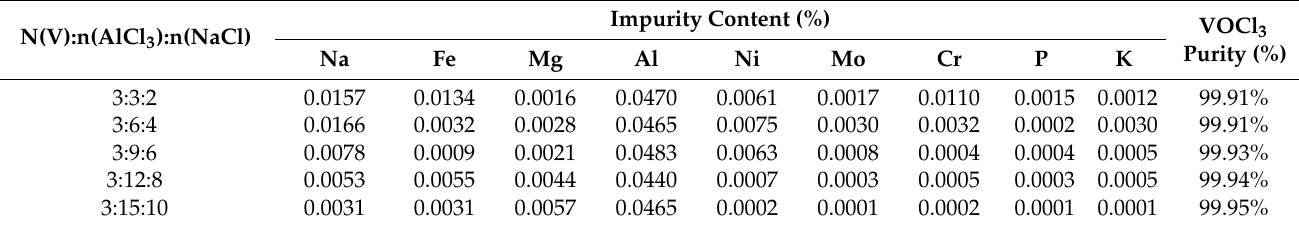
Figure 9. E ff ects of AlCl 3 and NaCl dosage on the vanadium extraction rate. Figure 9. Effects of AlCl 3 and NaCl dosage on the vanadium extraction rate. Table 5. E ff ects of AlCl 3 and NaCl dosage on the purity of VOCl 3 . Table 5. Effects of AlCl 3 and NaCl dosage on the purity of VOCl 3 .